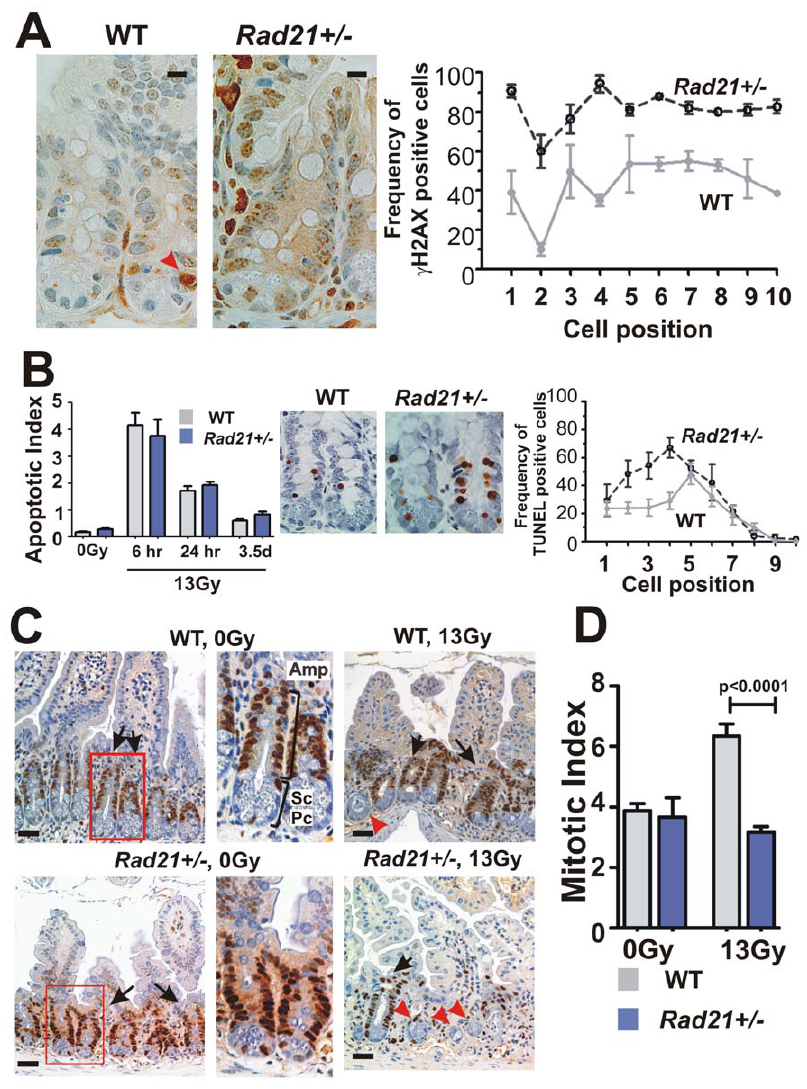
Figure 5. Cellular properties of small intestinal crypts post 13 Gy WBI. A . c H2AX immunostaining of small intestinal crypt 6 hours after IR. Representative images of WT (left panel) and Rad21 + / 2 (middle panel) are shown. The right panel shows the frequency of c H2AX-positive cells scored according to the cell positions relative to the base of crypts. At least 20 crypts per animal and three animals per genotype were scored. Red arrowhead: apoptotic cells. Scale bars=20 m m. B . Apoptotic cells determined by TUNEL staining at indicated time points post IR. Middle panels show the representative images of TUNEL-positive cells in crypts 6 hours post IR. Right panel show the frequency of TUNEL-positive cells, scored according to cell position. At least 20 crypts per animal and three animals per genotype were scored to determine the frequency. C . PCNA immunostaining of crypts 3.5 days post IR. Middle panels: enlarged images of boxed areas showing three compartments of a crypt: Paneth cells (Pc), putative stem cells (Sc) and transient amplifying cells (Amp). Black arrows: surviving crypts; Red arrowheads: non-surviving crypts. Scale bars=20 m m. D . Mitotic indices determined by phospho-Histone H3 immunostaining at 3.5 days post IR. At least four whole circumferences of small intestinal cross-sections were scored per animal. The number of animals scored is as follows: WT 0Gy n=5, 13Gy n=6; Rad21 + / 2 0Gy n=3, 13Gy n=10. Error